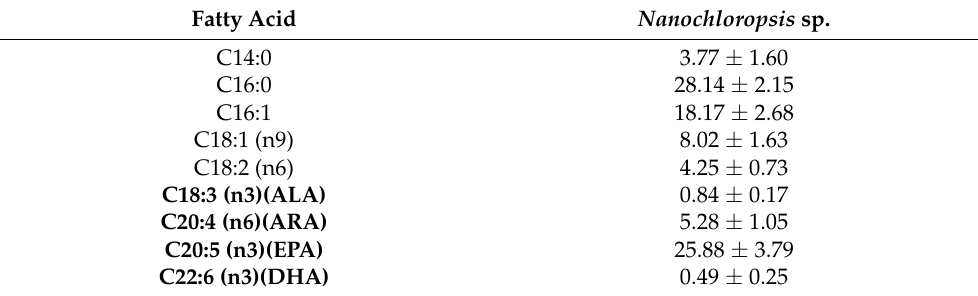
Table 6. Fatty acid composition (% total fatty acids) of Nannochloropsis sp. The bold fatty acid species are described in the results Fatty